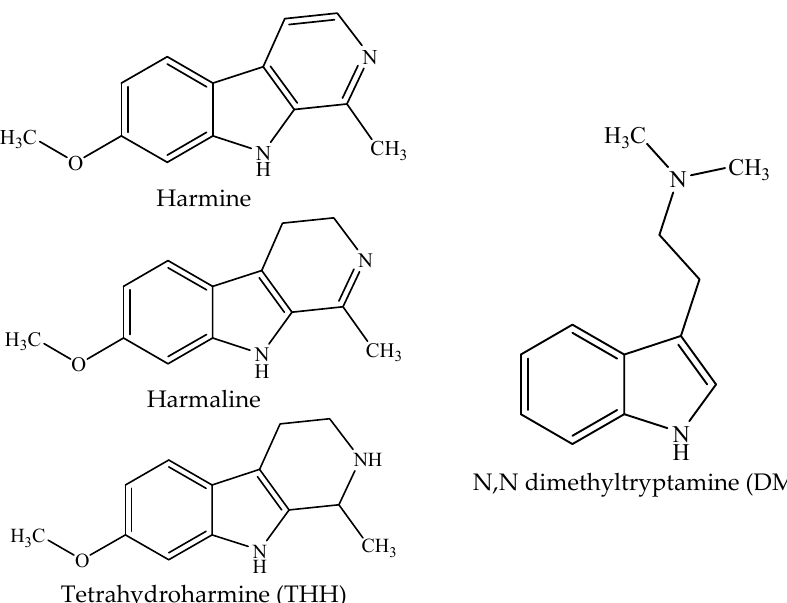
Figure 1. Chemical structures of the β -carbolines harmine, harmaline, and tetrahydroharmine (THH) present in Banisteriopsis caapi and ayahuasca and of N,N-dimethyltryptamine (DMT), present in ayahuasca.